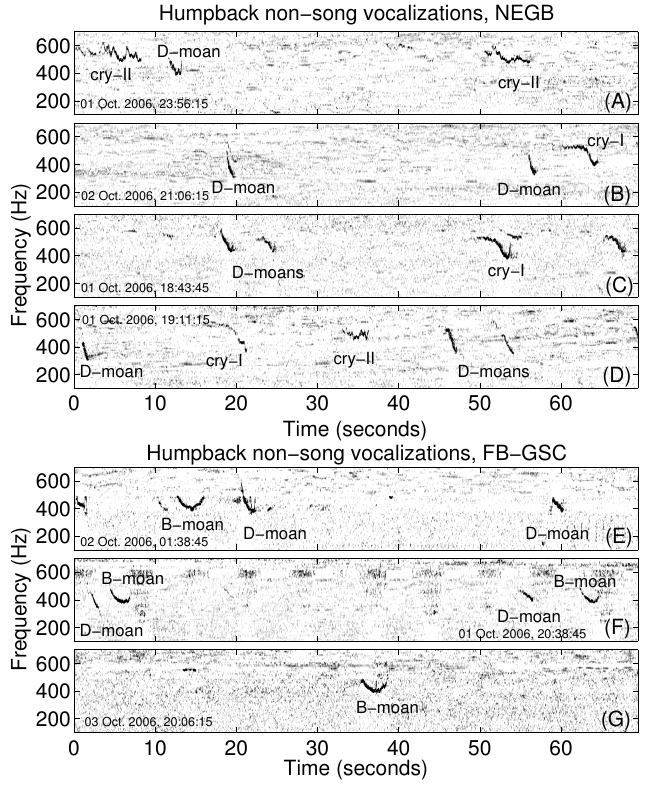
Figure 4. Examples of beamformed spectrograms containing humpback non-song vocalizations recorded during nighttime hours from 27 September to 3 October 2006 in the Gulf of Maine. Moans and cries originating from the NEGB direction are shown in ( A – D ). Moans originating from the FB-GSC direction are shown in ( E – G